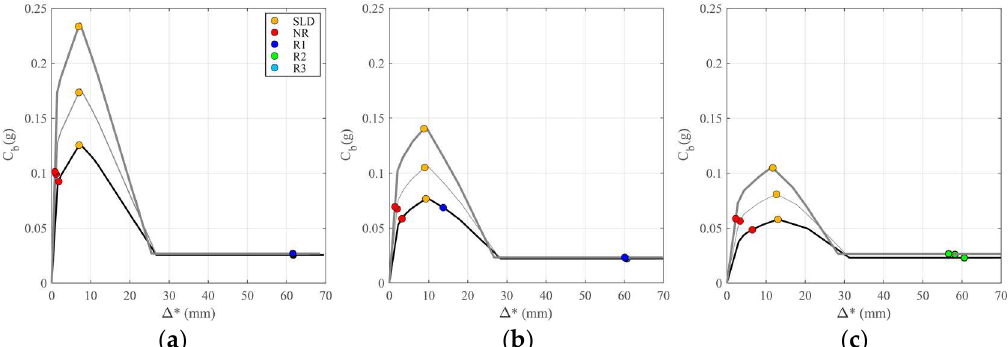
Figure 10. Capacity curves for the archetype buildings in transversal direction with mass proportional loads: ( a ) three-storey ( b ) five-storey, and ( c ) seven-storey building with W (bold black), M (thin gray) and S (bold gray) infills. Limit states for no retrofit NR and increasing retrofit levels of FRP + SRP solution are represented along the curves.